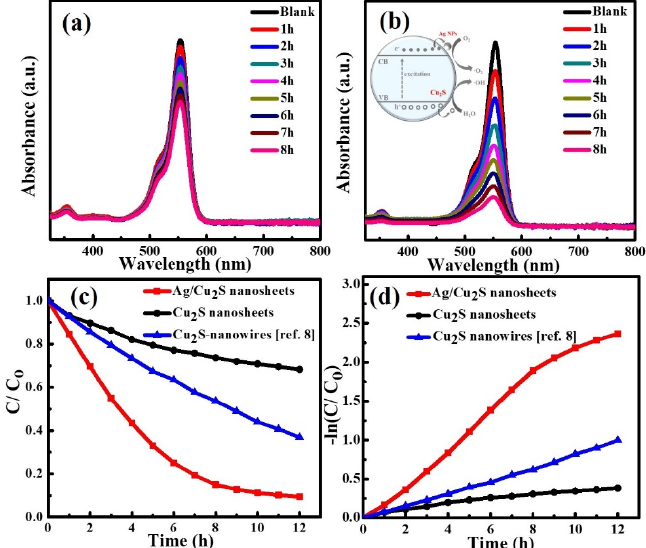
Figure 3. UV-visible absorption of RhB dye during the photodegradation process using ( a ) Cu 2 S and ( b ) Ag/Cu 2 S nanosheets. The inset illustrates the electron transfer process in Ag/Cu 2 S under light irradiation. ( c ) Relative change in concentration of the RhB dye during the photodegradation over different photocatalysts. ( d ) Kinetics of photodegradation and apparent rate constant (K) using three different catalysts. Photodegradation results of Cu 2 S nanowires were mentioned in our previous report [8].